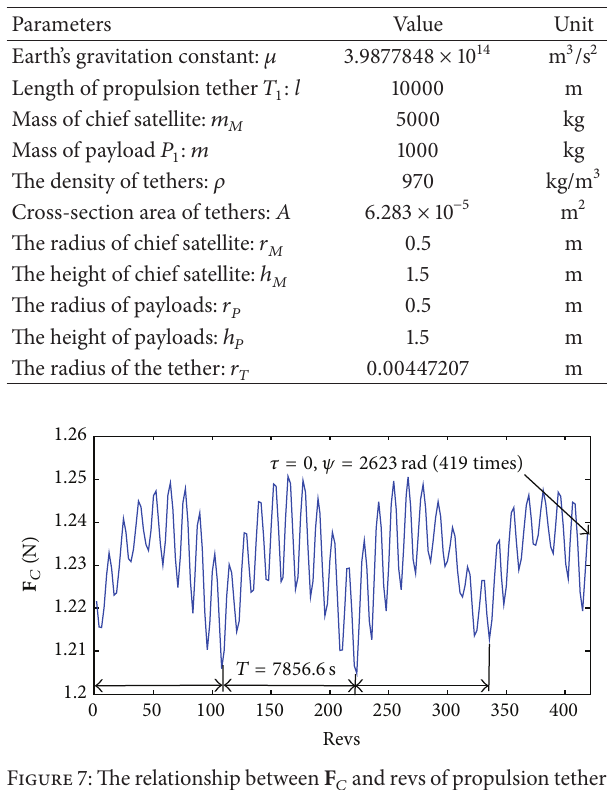
Table 2: Parameters of the MMET.